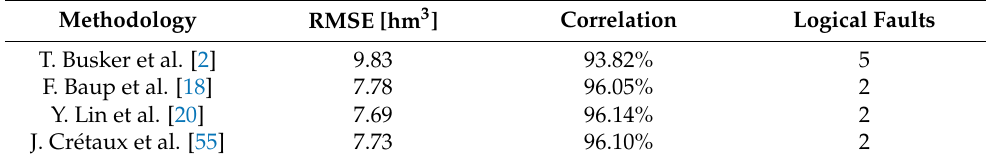
Figure 12. Comparison of observed storage variation with the estimation methodologies. Table 1. Comparison of the applied methodologies for the estimation of Yliki reservoir storage variation.